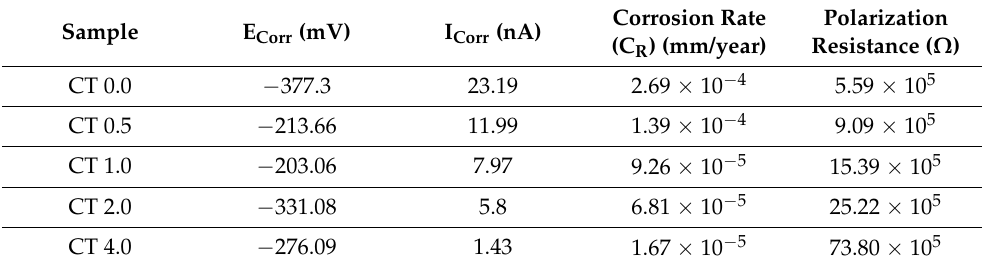
Figure 12. Tafel Polarization Plot of NIPU and its Composite Films . Table 5. Tafel Polarization Data of NIPU Composite Films.